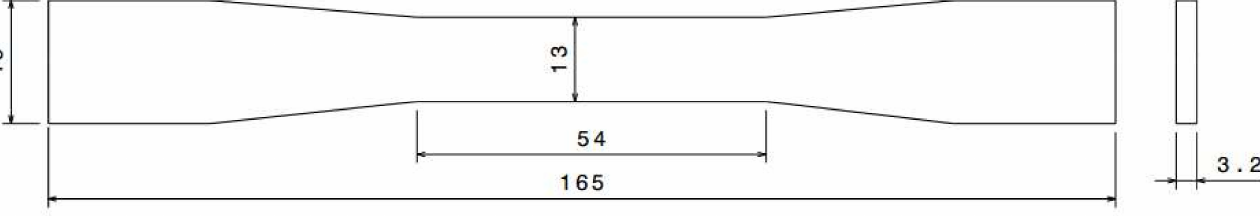
Figure 1. The ASTM D638-I tensile test